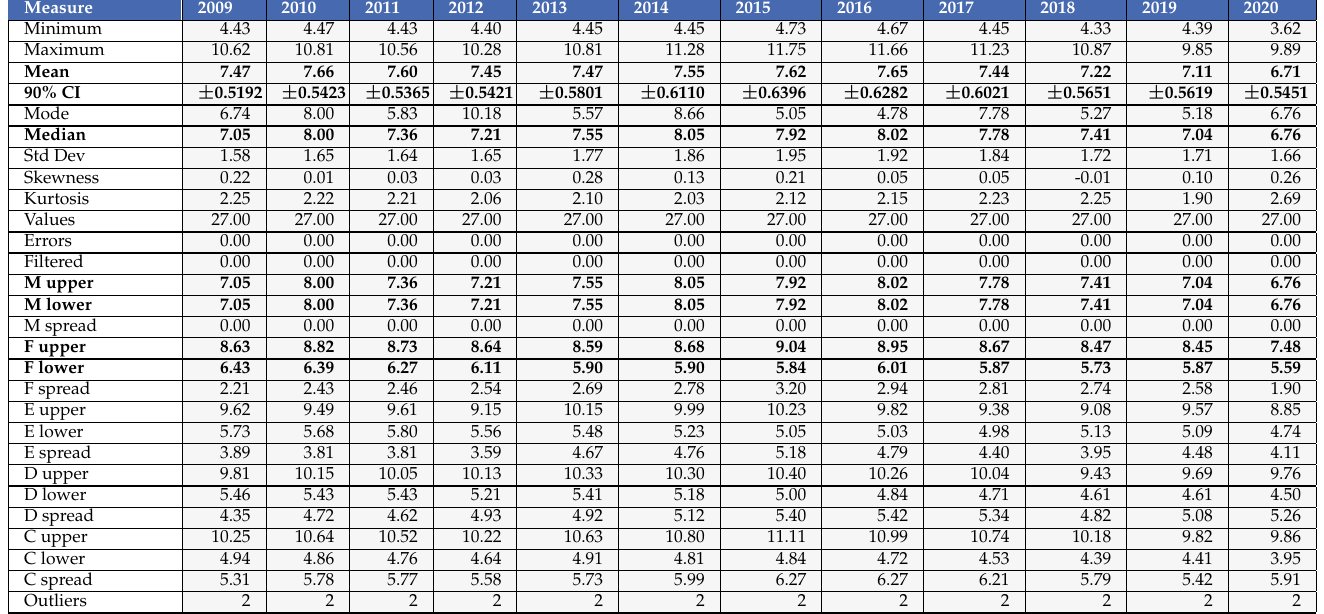
Table A3. Letter values—the share of environmental tax revenues in the total tax revenues of the EU27 in 2009–2020 (source: own study).